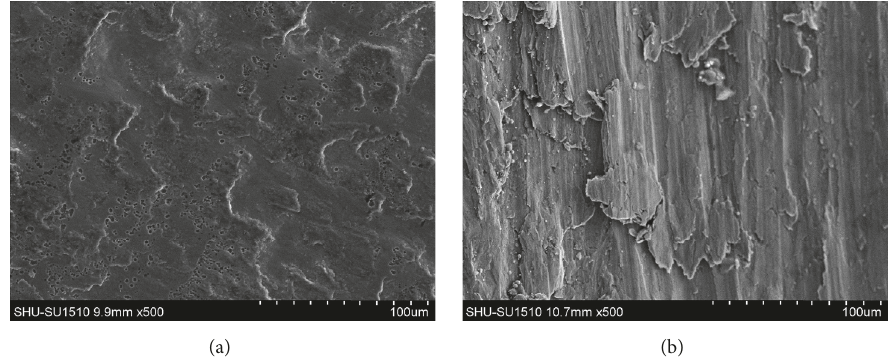
Figure 3: Wear scars of (a) chroming and (b) nonchroming T10 discs after dry sliding.